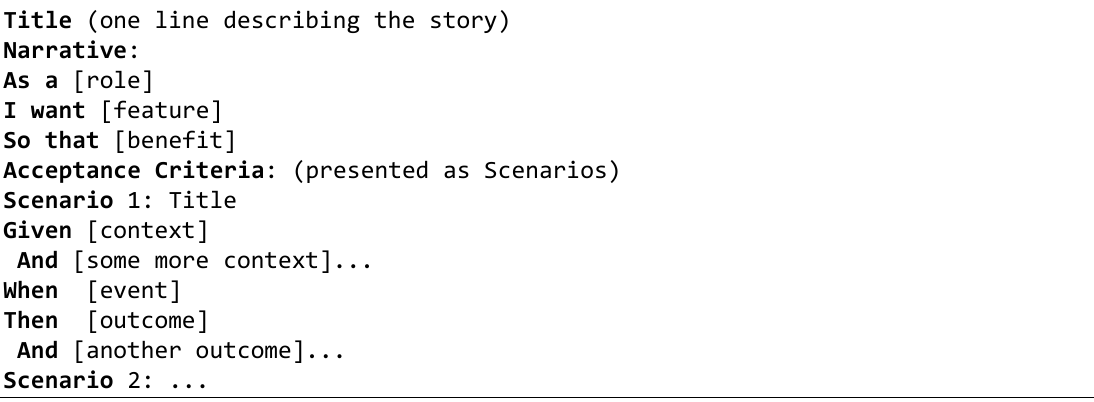
Figure 2. Template for specifying User Stories as defined by North [16] and Cohn